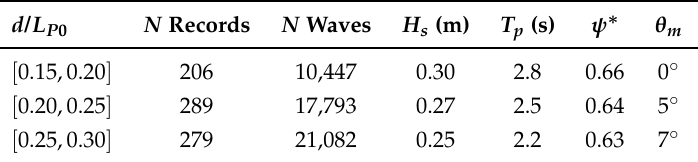
Table 1. Characteristics of the recorded sea